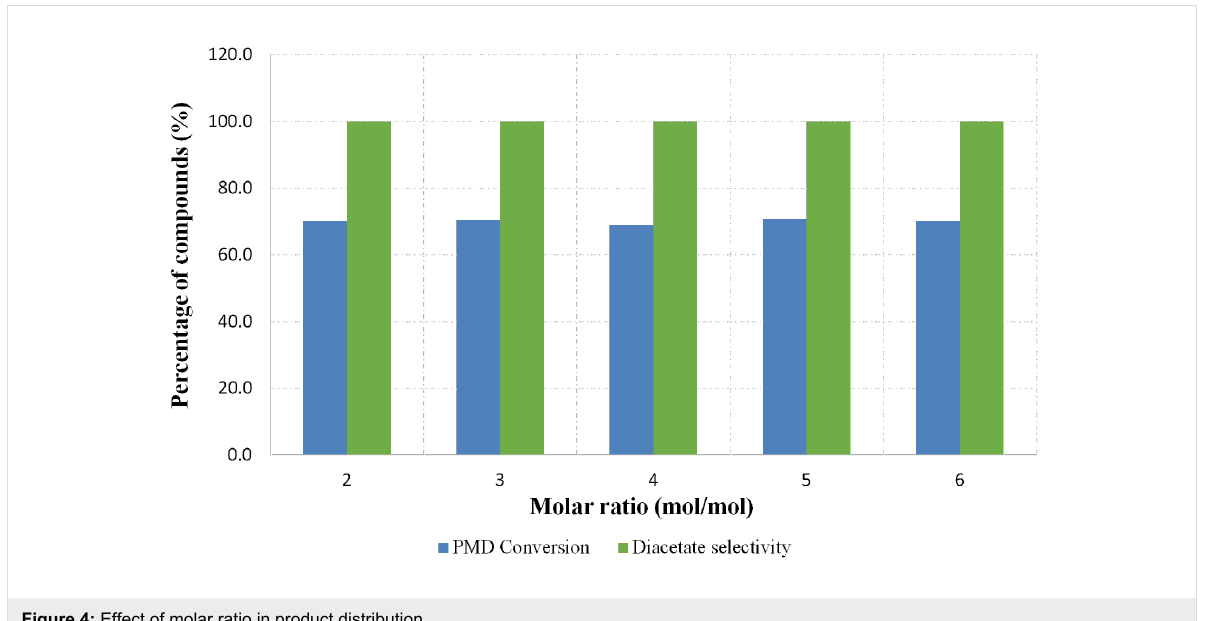
Figure 4: Effect of molar ratio in product